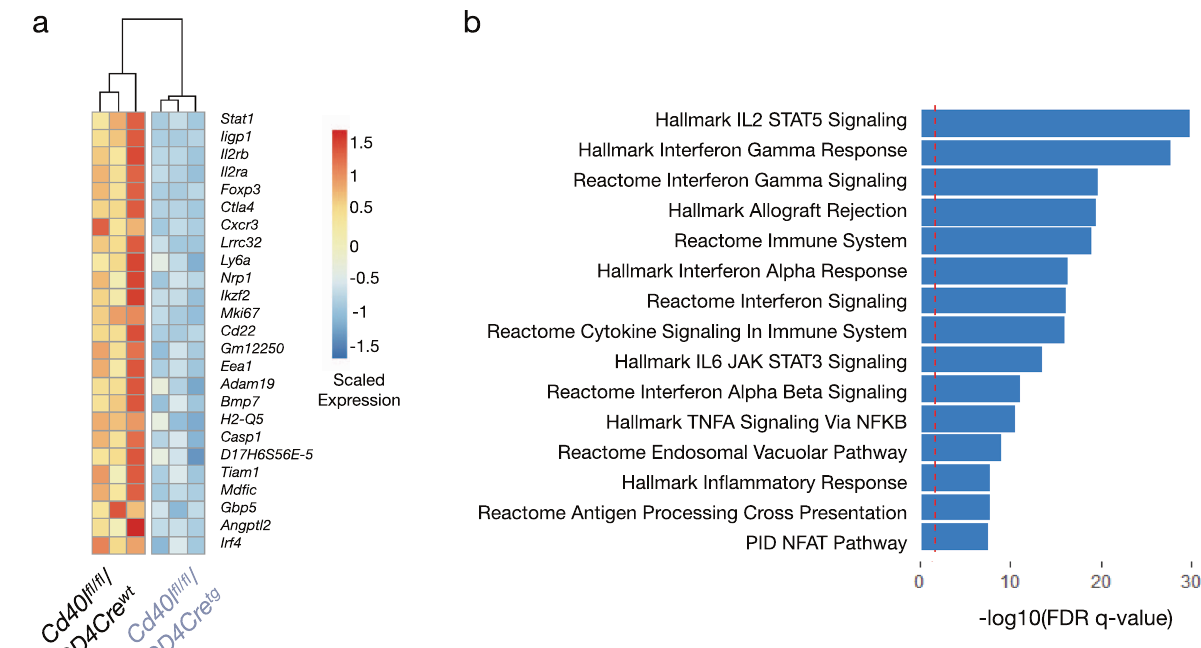
Fig. 4 RNA sequencing con fi rms dysregulation of Th1 and Treg pathways in CD40L de fi cient T cells. a Heatmap of top 25 downregulated genes in Cd40l fl / fl /Cd4Cre tg CD4 + T cells (right) compared to CD4 + T cells from their wild type littermates (left) [ n = 3]. Data are normalized as reads per kilobase million with signi fi cance noted as a p adjusted value < 0.05 (corrected Benjamini – Hochberg). b Geneset enrichment analysis (GSEA) displaying the top 15 signi fi cantly enriched canonical and hallmark gene sets associated with downregulated genes in Cd40l fl / fl /Cd4Cre tg CD4 + T cells. n refers to biologically independent